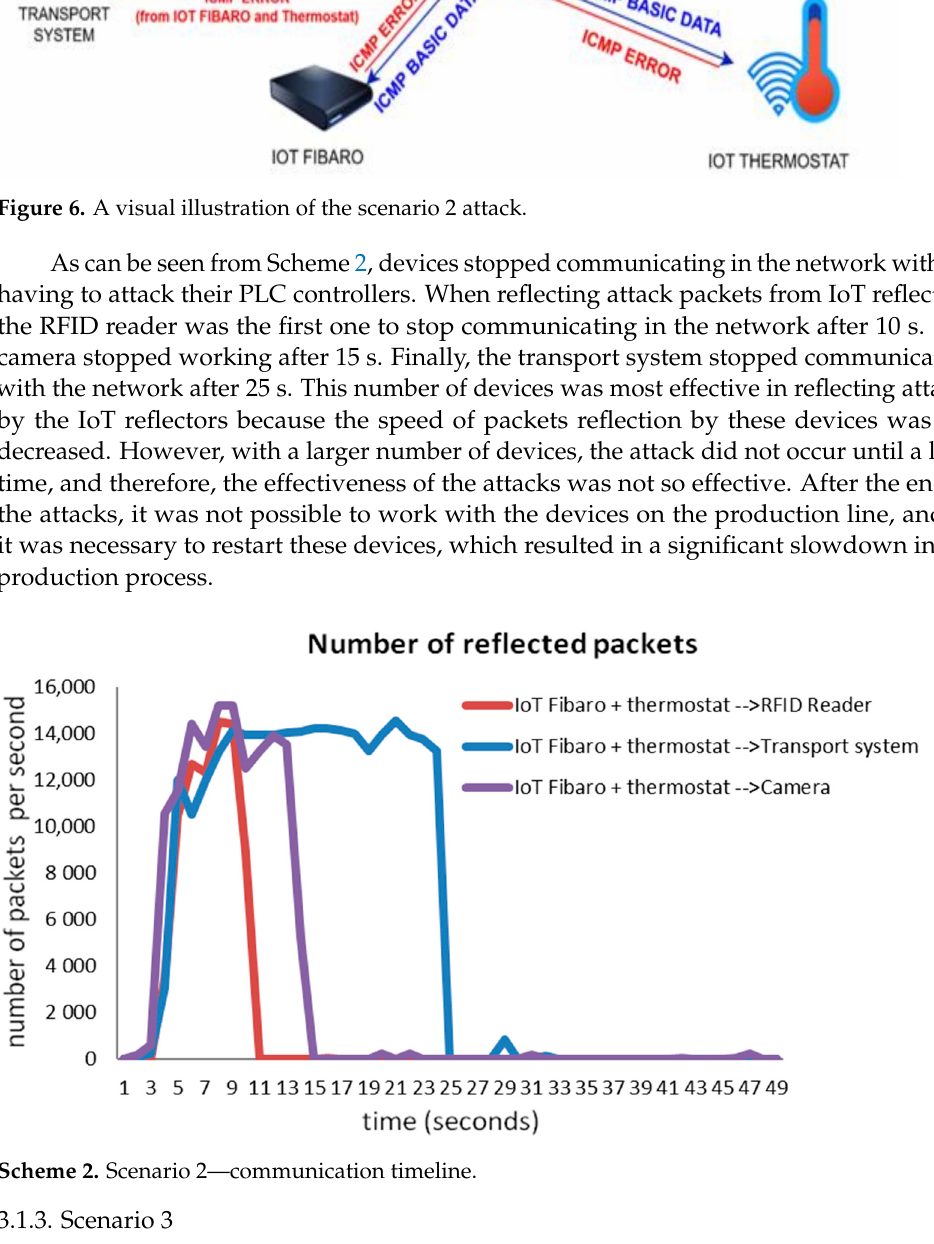
Scheme 2. Scenario 2 — communication